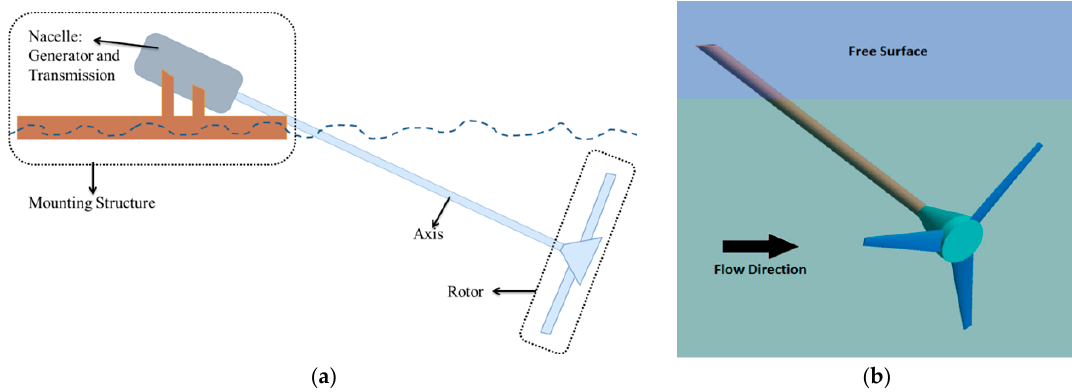
Figure 1. The schematics of the inclined hydrokinetic turbine showing its components ( a ) and isometric view of the geometrical model ( b ).